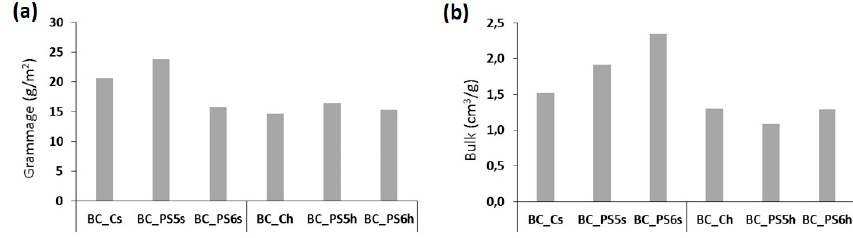
Figure 5. ( a ) Grammage (g/m 2 ) and ( b ) bulk (cm 3 /g) of the samples.